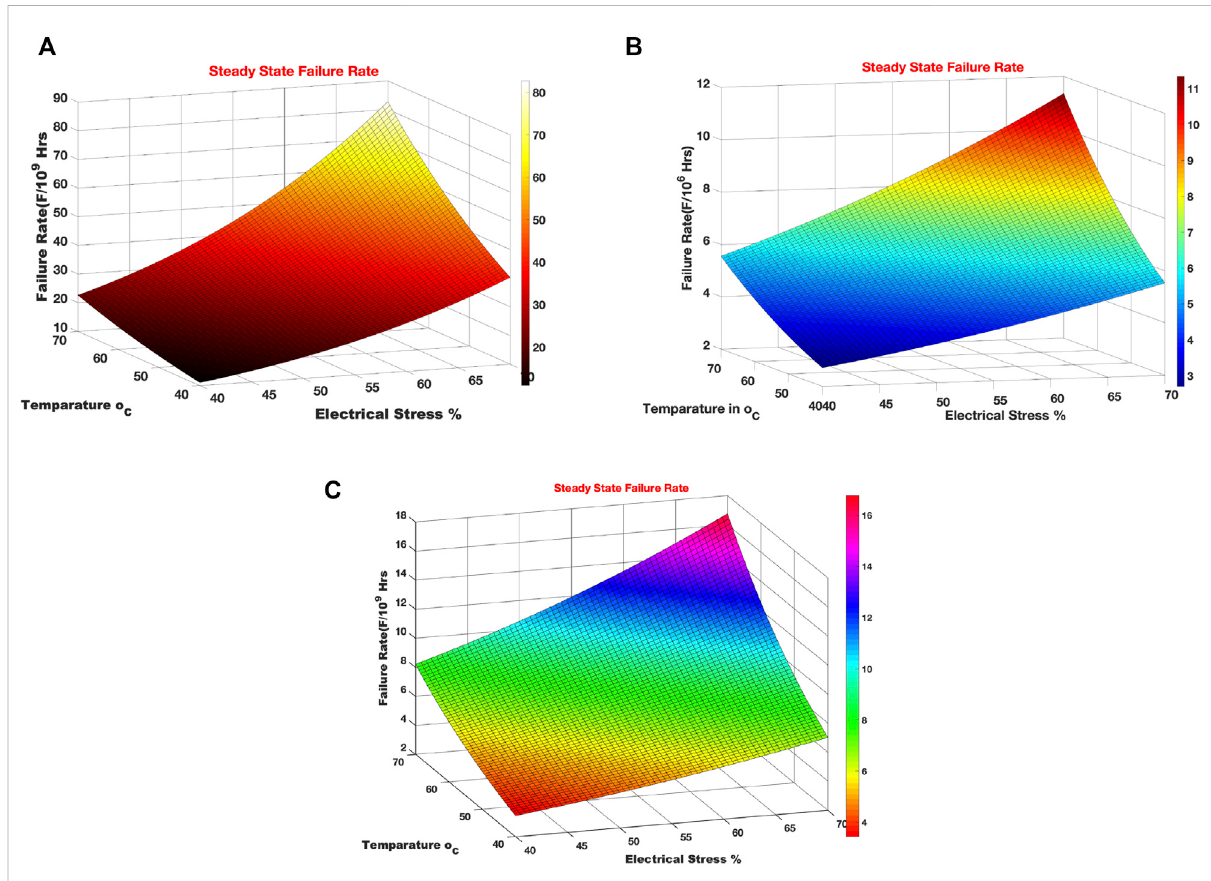
FIGURE 7 The component failure rate with respect to thermal and electrical stress (A) Electrolytic capacitor (B) MOSFET (C) Diode.